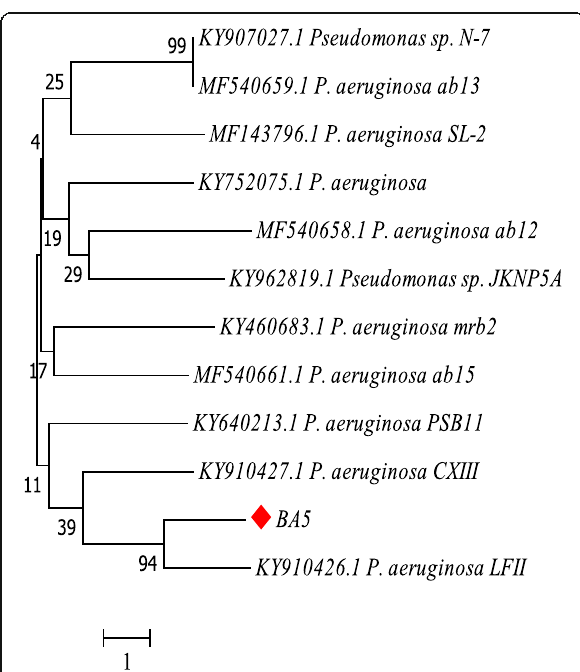
Fig. 3 Neighbor-joining phylogenetic tree showing relationships between isolate BA5 (red rectangular) and several other strains of Pseudomonas aeruginosa based on their 16S rRNA gene sequences. The tree was constructed in MEGA7 using the neighbor-method with 1000 bootstrap